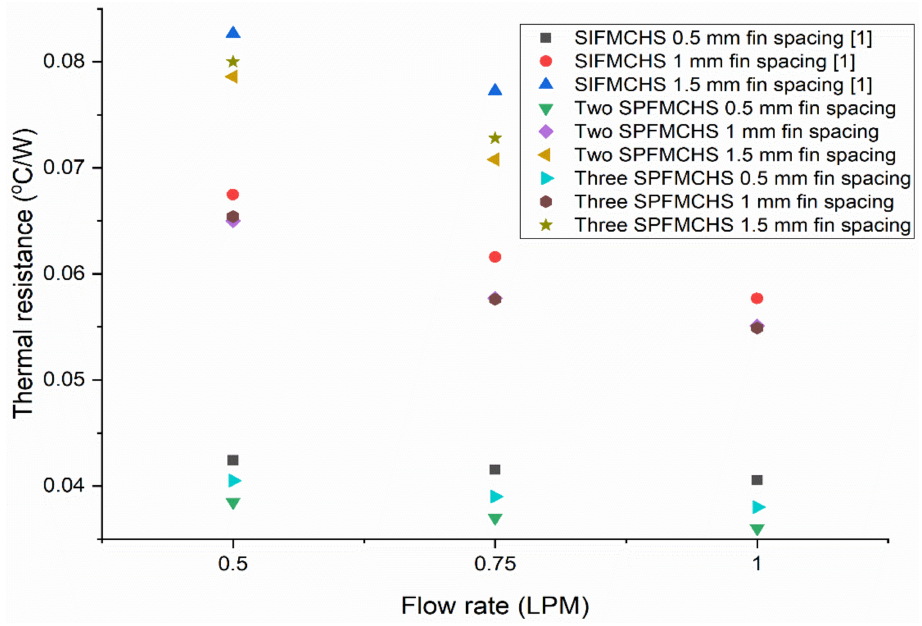
Figure 15. Thermal resistance with volumetric flow